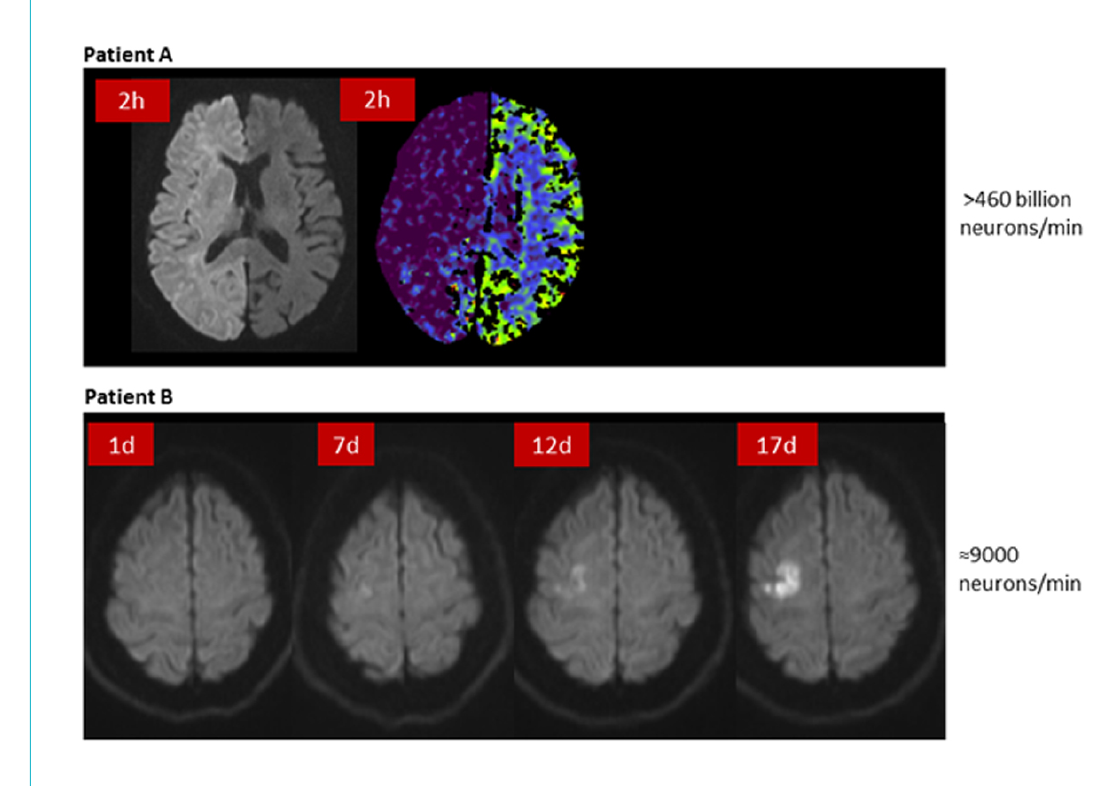
Figure 4: Variable velocities of infarct growth. Patient A: carotid T occlusion and fetal type posterior cerebral artery, 2 hours after symptom on- set hyperintensity of the whole hemisphere in diffusion-weighted imaging (DWI) with corresponding hypodensity in CT perfusion (CBV). Pa- tient B: persistent carotid occlusion, slow infarct growth in DWI over 17 days. Neuronal cell loss was estimated based on volumetric measure- ment of the lesion and the average neuronal density described in Saver et al. [13] (Pictures: Stroke Centre